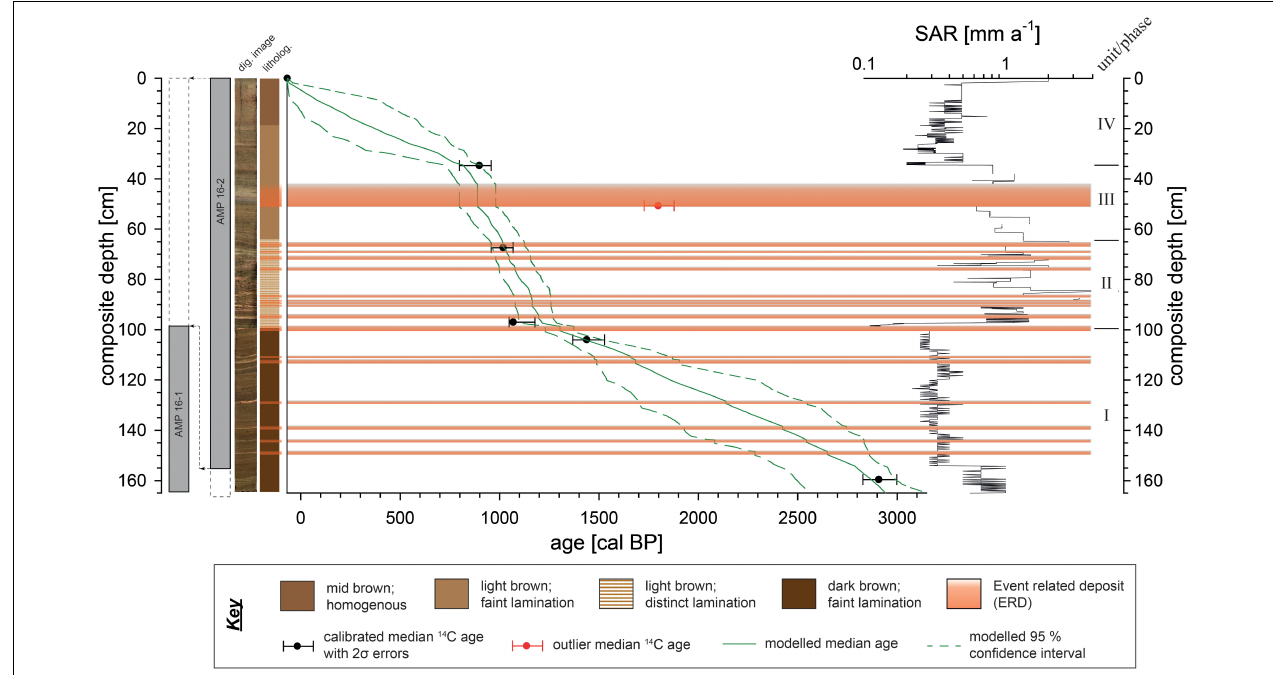
FIGURE 2 | Transition between the sediment cores AMP 16 1 and 16-2, digital image, lithological sketch, age-depth model and sediment accumulation rate (SAR) of composite sequence AMP-16. The composite was established based on parallelization of visual marker layers as well as magnetic susceptibility patterns of the two sediment gravity cores AMP 16-1 and AMP 16-2 ( Supplementary Figure 1 ). Age-depth relation is based on a Bayesian model (Blaauw and Christen, 2011) with medians and the 2 σ error ranges of five AMS calibrated 14 C ages using the SHCal20 dataset (Hogg et al., 2020). Centimeter-scale SAR variability are an artifact that does not provide a centimeter-scale prediction of SAR but merely a range of possible SAR in different core